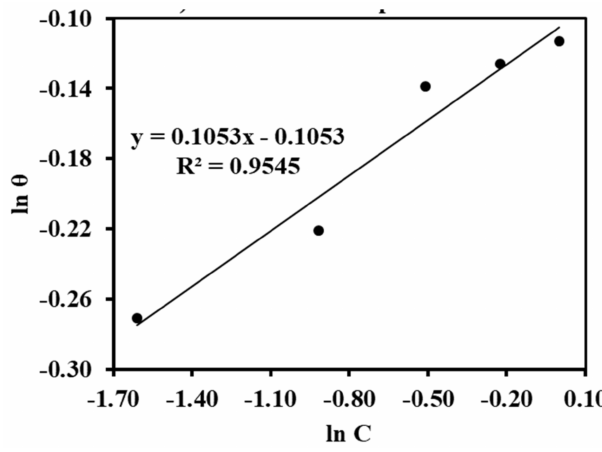
Figure 10. Freuldlich adsorption plot.